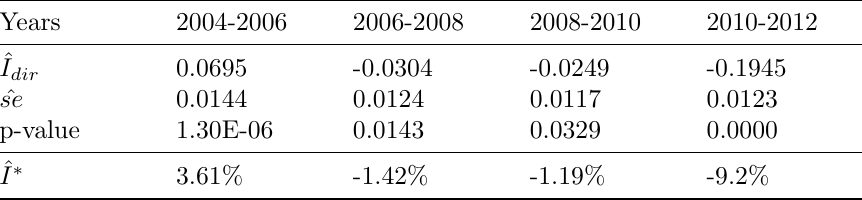
Sampling directional indices and p-values for the one-sample test ( H 0 : I dir ( P ) = 0